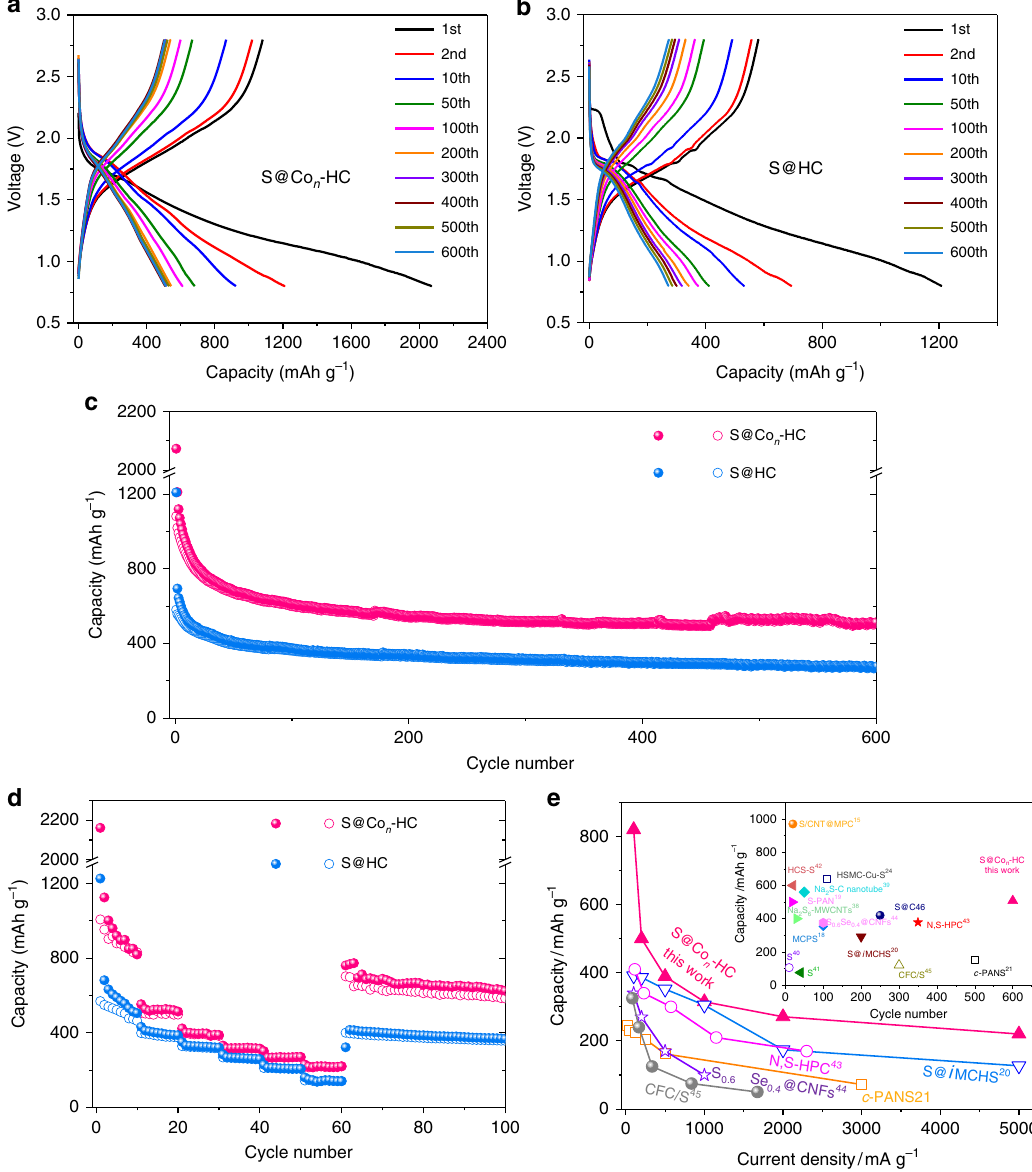
Fig. 4 Room-temperature sodium-sulfur battery test. a , b Discharge/charge curves of atomic cobalt-decorated hollow carbon sulfur host (S@Co n -HC) and hollow carbon hosting sulfur (S@HC) at 100 mA g − 1 . c , d Cycling performance and rate performance for S@Co n -HC and S@HC. e Comparison of the rate and cycling (inset) capabilities of previously reported room-temperature sodium-sulfur (RT-Na/S) batteries with our